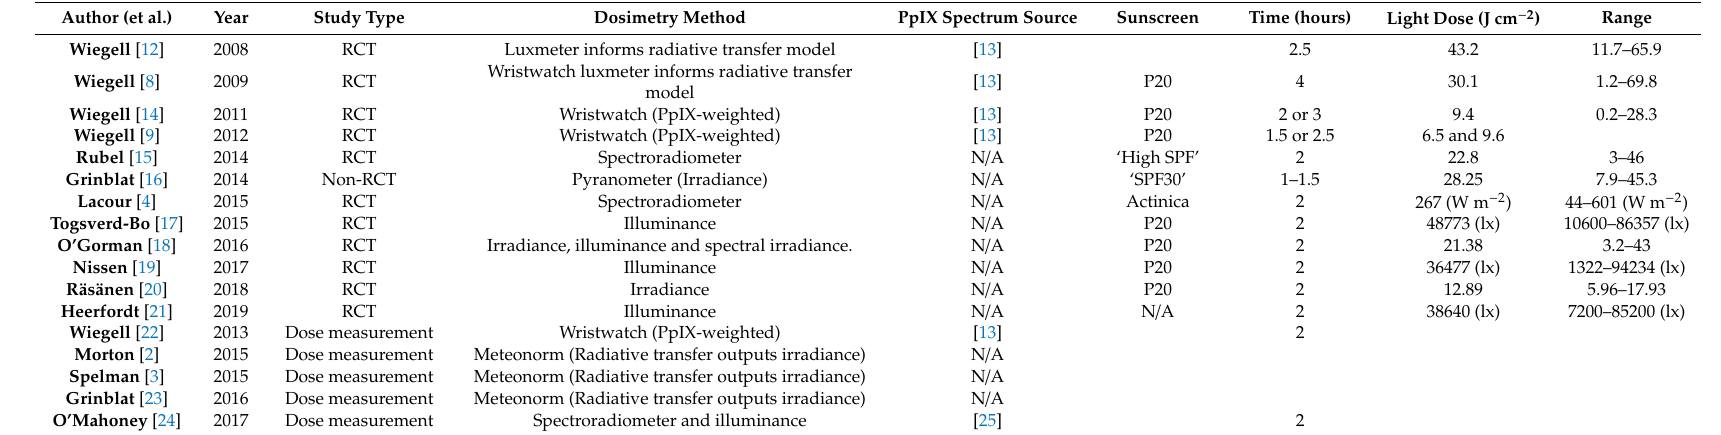
Table 1. Summary of DPDT studies carrying out dosimetry, and studies investigation location-based dosimetry